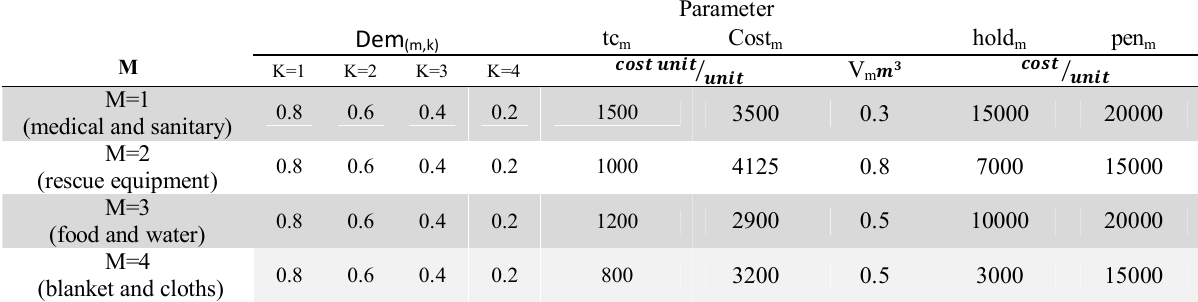
Parameters related to type of